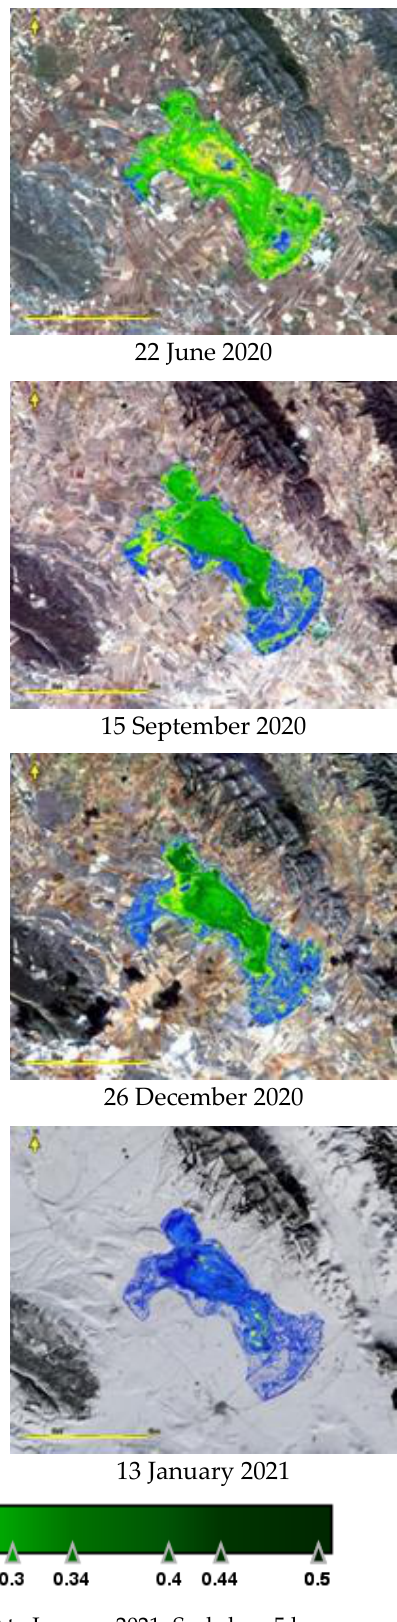
Figure A5. NDI45 evolution over a year: January 2020 to January 2021. Scale bar: 5 km.